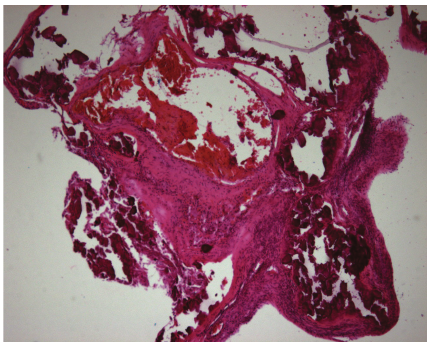
Figure 3: Coronary endarterectomy showed atherosclerotic plaques and